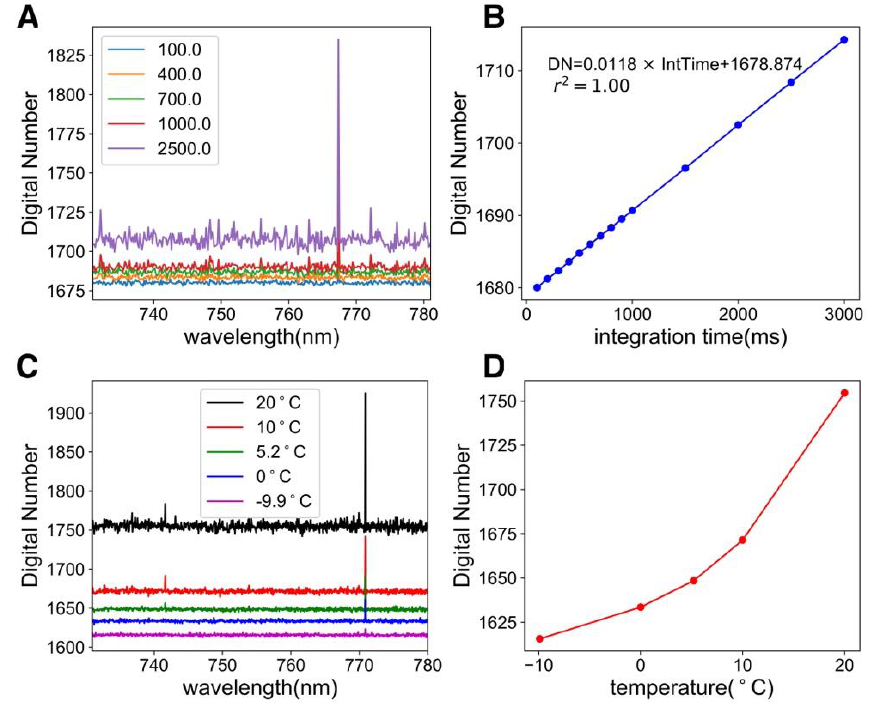
Figure 4. ( A ) Dark current under various integration times (100 ms, 400 ms, 700 ms, 1000 ms, and 2500 ms). ( B ) The relationship between integration time and the dark current. ( C ) Dark current collected at different TEC temperatures. ( D ) Non-linear relationship between temperature and dark current, indicating the importance of keeping a stable detector temperature.